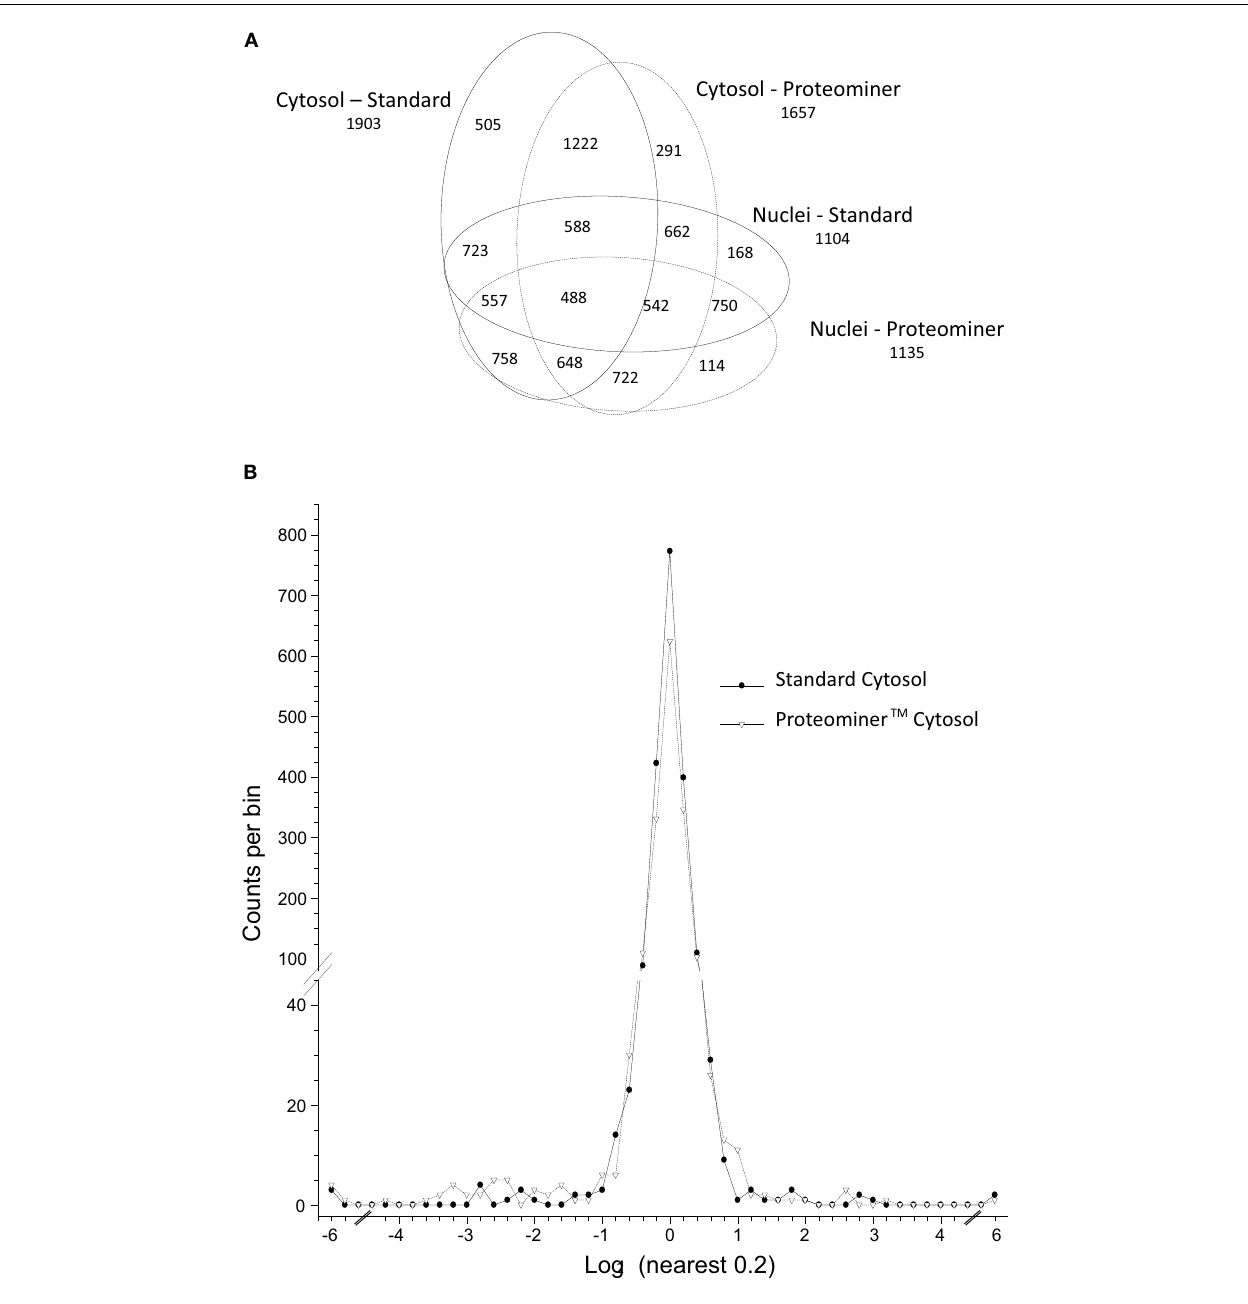
FIGURE 3 | Distributions of proteins identified in various experiments. (A) Venn diagram of numbers of identified proteins from various analyses. (B) Frequency distributions of identified proteins in two virus-infected sample sets, with H:L ratios expressed as log 2 values. Positive values represent